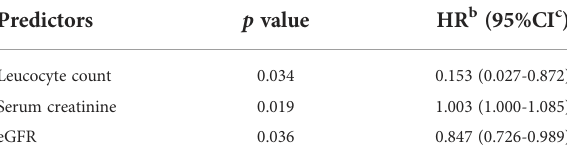
TABLE 3 Multivariable predictors of a ESRD in DPPs by multivariate COX regression analysis. Predictors